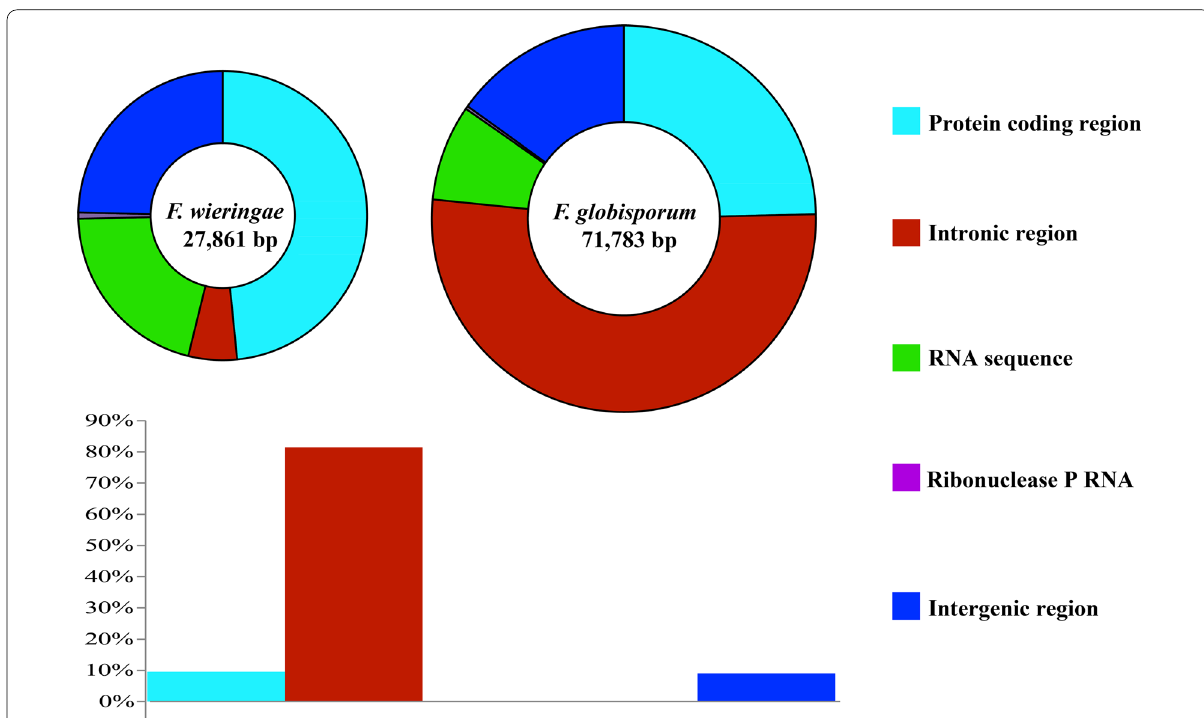
Fig. 2 Mitogenome composition of the entire mitochondrial genomes of the two Filobasidium species. The bottom panel shows the contribution of different gene regions to the expansion of the F. globisporum mitogenome. The y-axis represents the contribution rate of different regions to the size variation of the whole mitogenome, which is calculated by the following formula: size difference of region / size different of the entire mitogenome